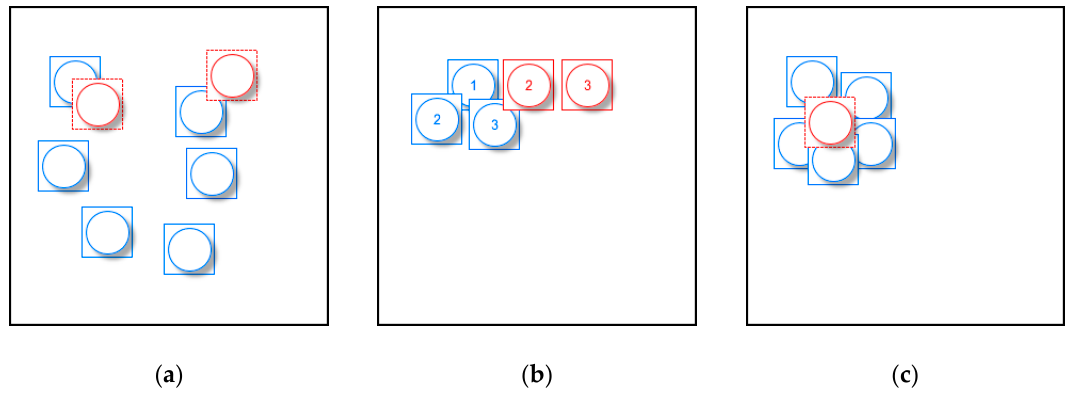
Figure 1. Problems in current point data generalization methods: ( a ) the red symbols will be abandoned using a selection operation; ( b ) the blue symbols will drift using a displacement operation; ( c ) the red symbol will be abandoned in high-density areas.